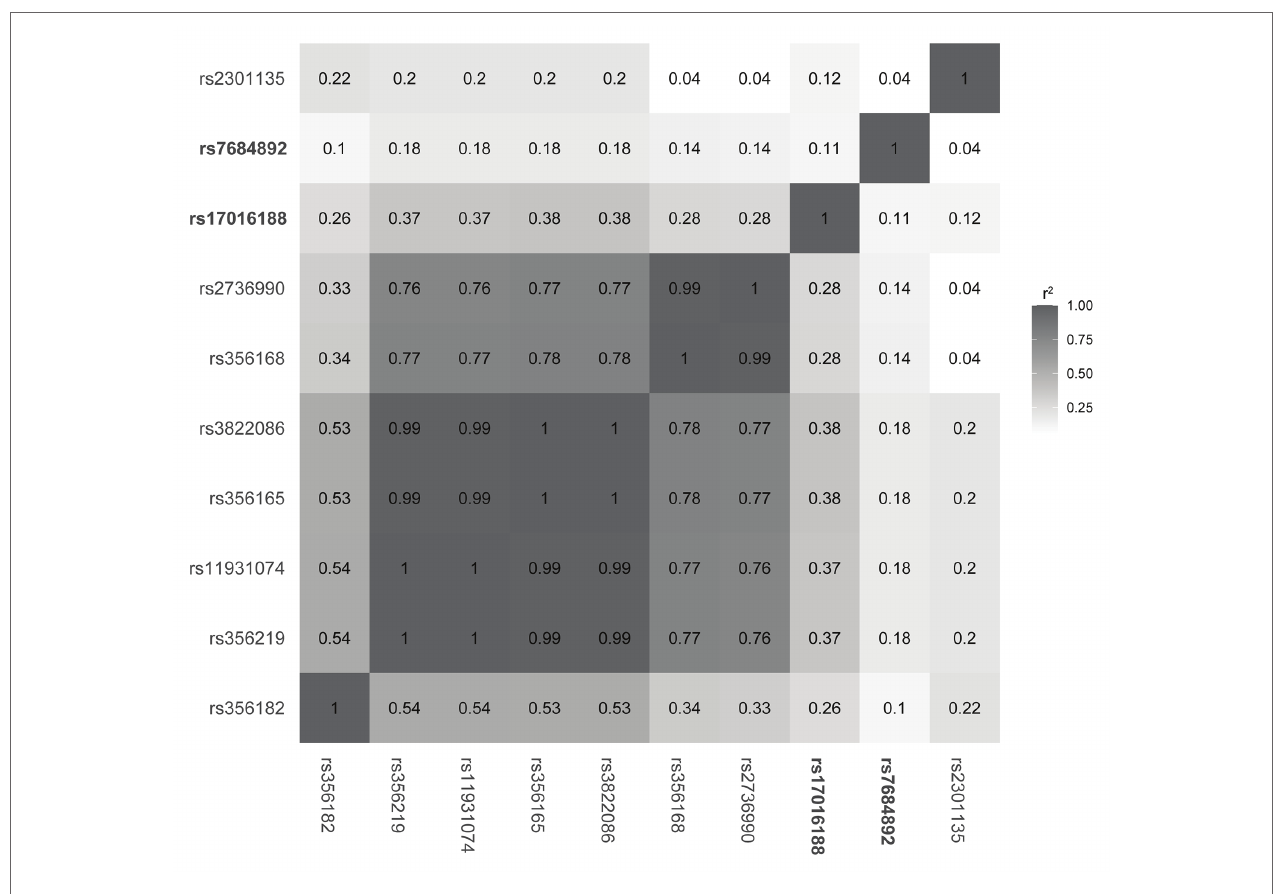
FIGURE 1 | Linkage disequilibrium structure of the SNCA loci.